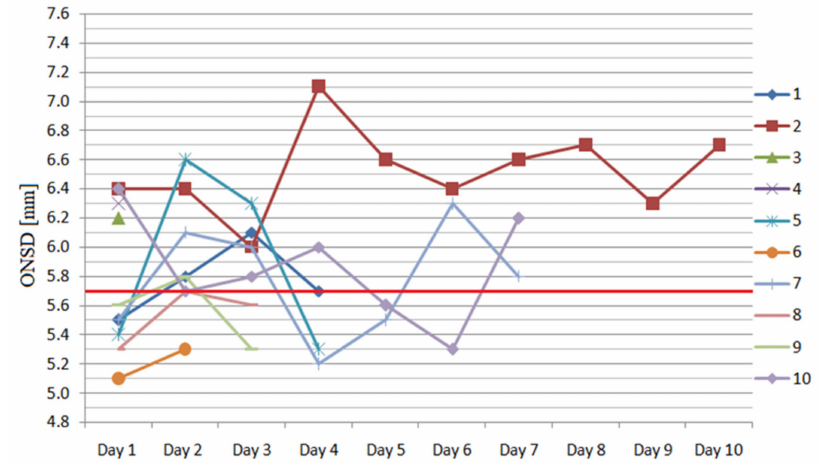
Figure 1. The consecutive measurements of the right eyeball optic nerve sheath diameter (ONSD) during the study period (red transverse line shows the cut-o ff